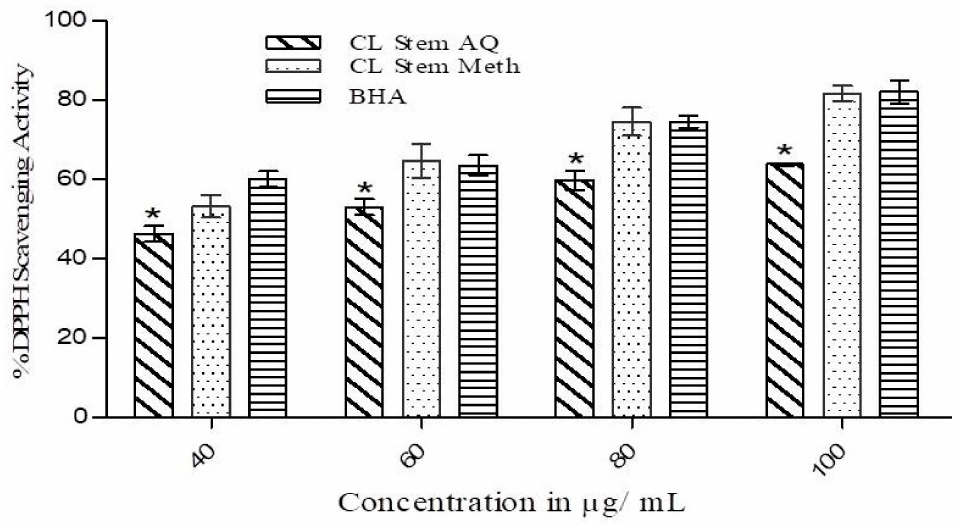
Figure 2. Free radical scavenging activity of methanolic (Meth) and aqueous (AQ) extracts of C. lanceolatus stem. Radical scavenging activity was determined at various concentrations of both extracts (40–100 µ g / mL). Butylated hydroxyl anisole (BHA) was used as a control. The results are expressed as a mean ± SD of three replicates. * p < 0.05 compared to